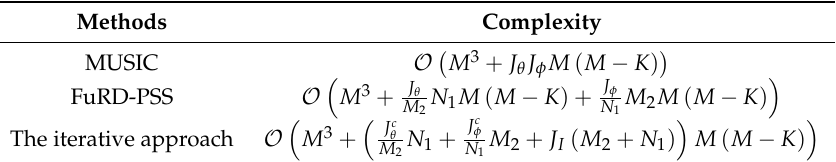
Table 1. The complexities of different methods. FuRD-PSS, full information-based reduced dimension partial spectral